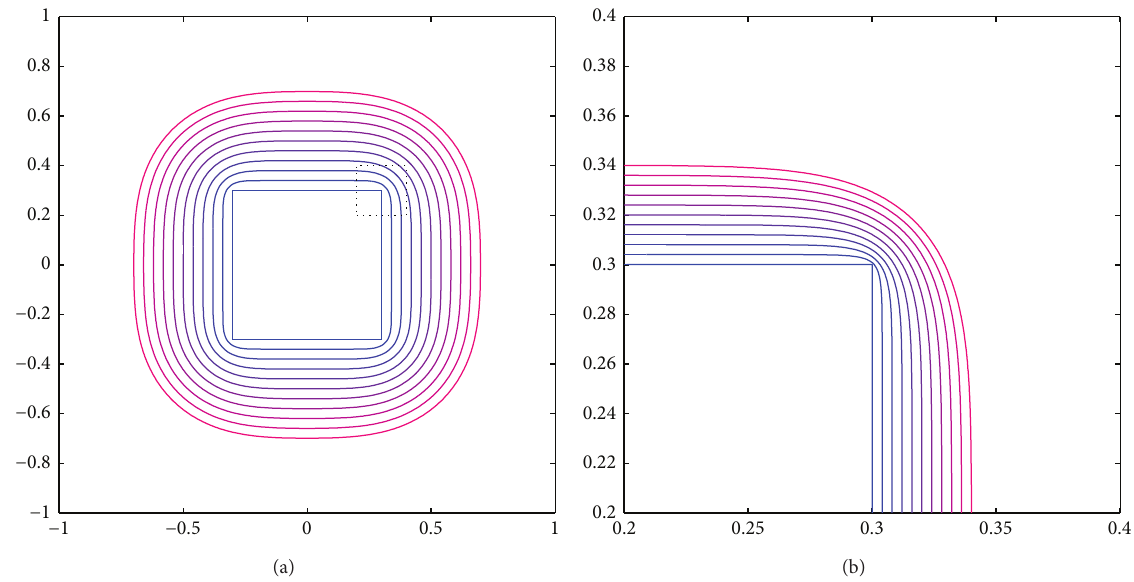
Figure 4: (a) The equivolumetric evolution starting from a rectangular initial flame is illustrated. The initial front is a square centered at the origin whose length of a side is 0.6. The evolution speed is given by (21) with the volumetric ratio 𝑆 0 = 0.04 , which is the same as the speed of planar flame in Figure 1. The sequence of fronts is plotted from 𝑡 = 0 to 𝑡 = 10 with Δ𝑡 = 1 . (b) This plot shows an enlargement of the motion of the front near the corner marked as a dotted box on (a). This is the motion of the front from 𝑡 = 0 to 𝑡 = 1 with Δ𝑡 = 0.1